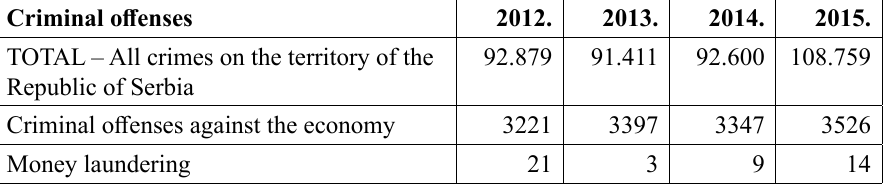
Table 1. Number of reported adult persons for crimes against the economy and the total for all crimes on the territory of the Republic of Serbia in the period 2012-2015.